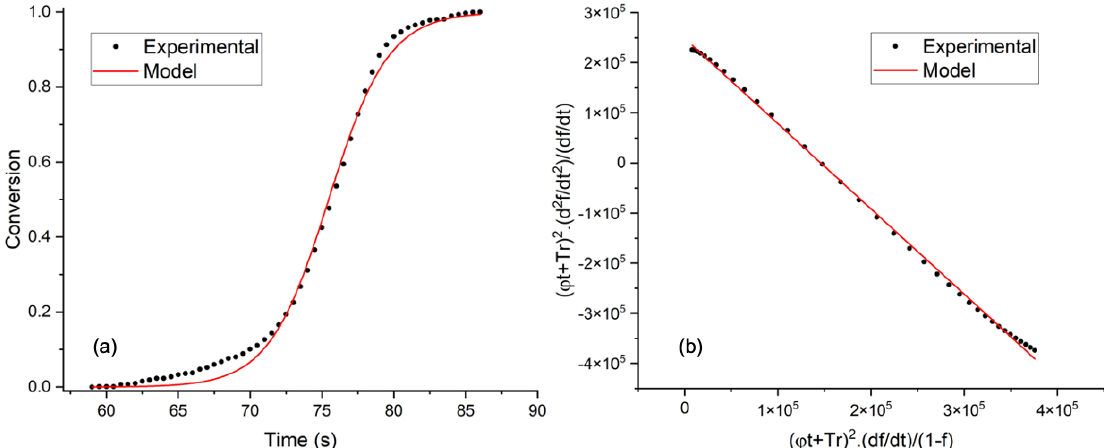
Figure 6. Graphical adjustments for thermal decomposition of ZnSO 4 · H 2 O in the presence of Pd/Al 2 O 3 : ( a ) conversion fraction as a function of temperature; ( b ) linearization of conversion data. In both cases, the model seems to be well fitted, as the R 2 values between experimental (scatter) and model (continuous line) datasets are close to unity. These results support and are consistent with the determined kinetic parameters of the thermal decomposition of pure zinc sulfate and the mixture of ZnSO 4 and Pd/Al 2 O 3 catalyst. The results are displayed in